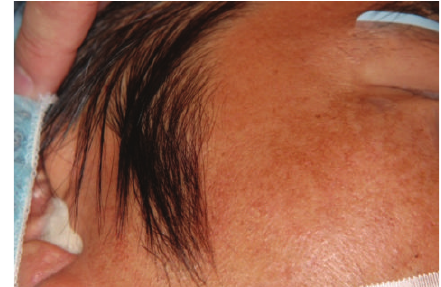
Figure 1: Revealed mass at the right preauricular area.